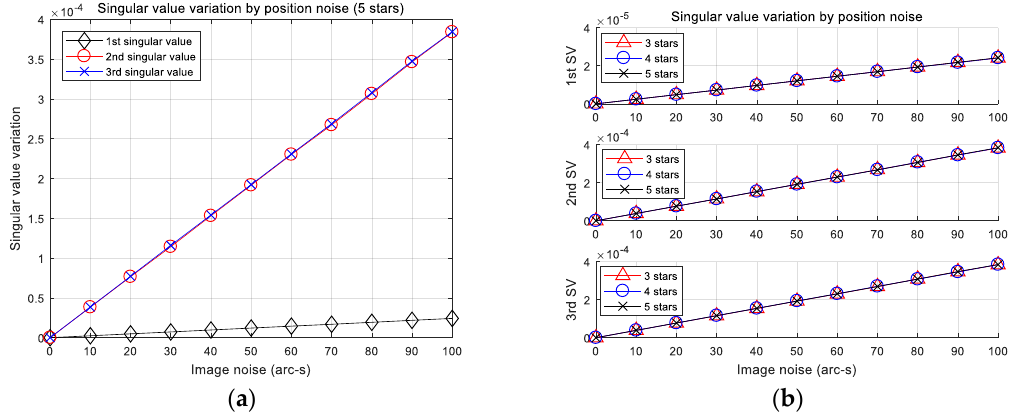
Figure 4. ( a ) Average error of each singular value of subsets of five stars; ( b ) comparison of average error of subsets of three, four, and five stars. Table 1. Defined discretization parameter and distribution range of each subset. Parameter for